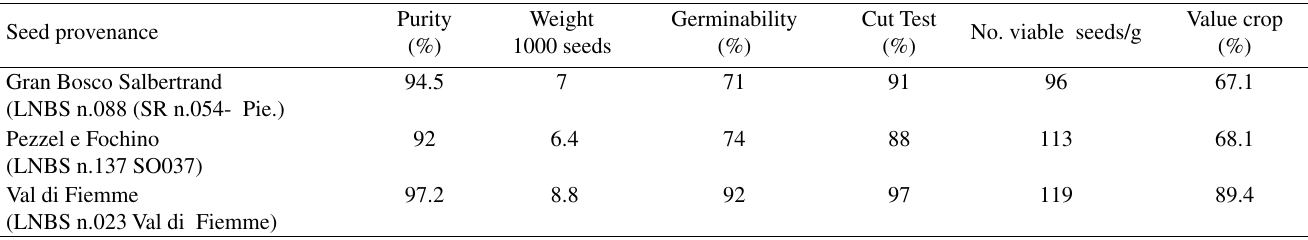
Table 1 - Certification of seed quality Seed